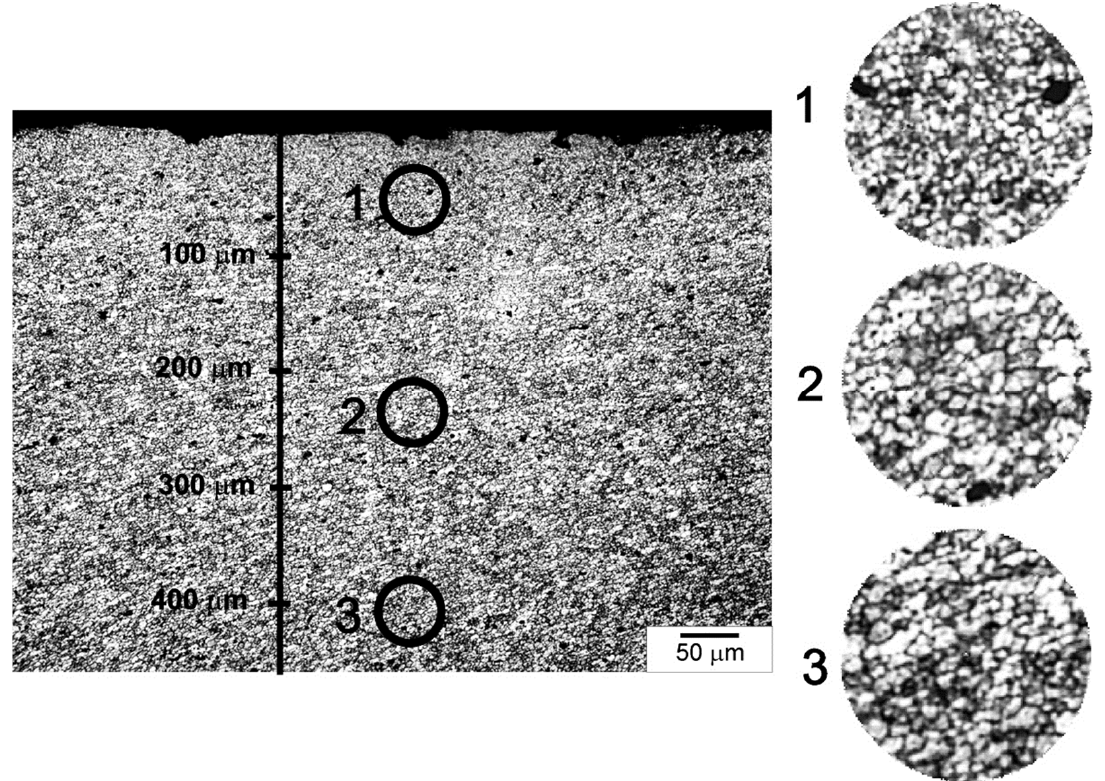
Figure 10. Differences in degree of grain refinement as function of distance from surface. AC90 sample. Sample etched. Light microscopy.